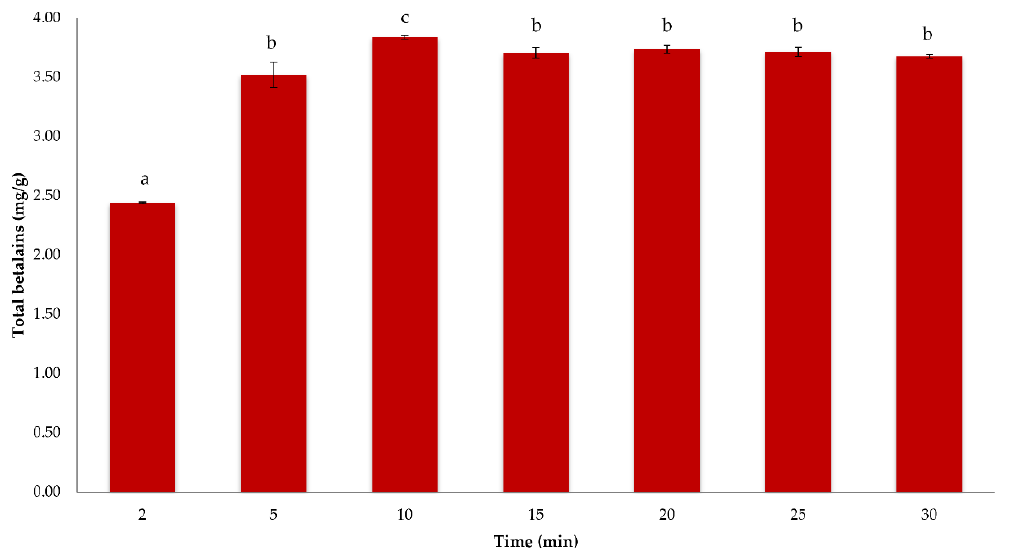
Figure 4. Total betalains (mg/g) obtained from Opuntia dillenii fruits according to the different extraction times tested. Different letters indicate significant differences with 95% of confidence according to Duncan’s post hoc analysis.